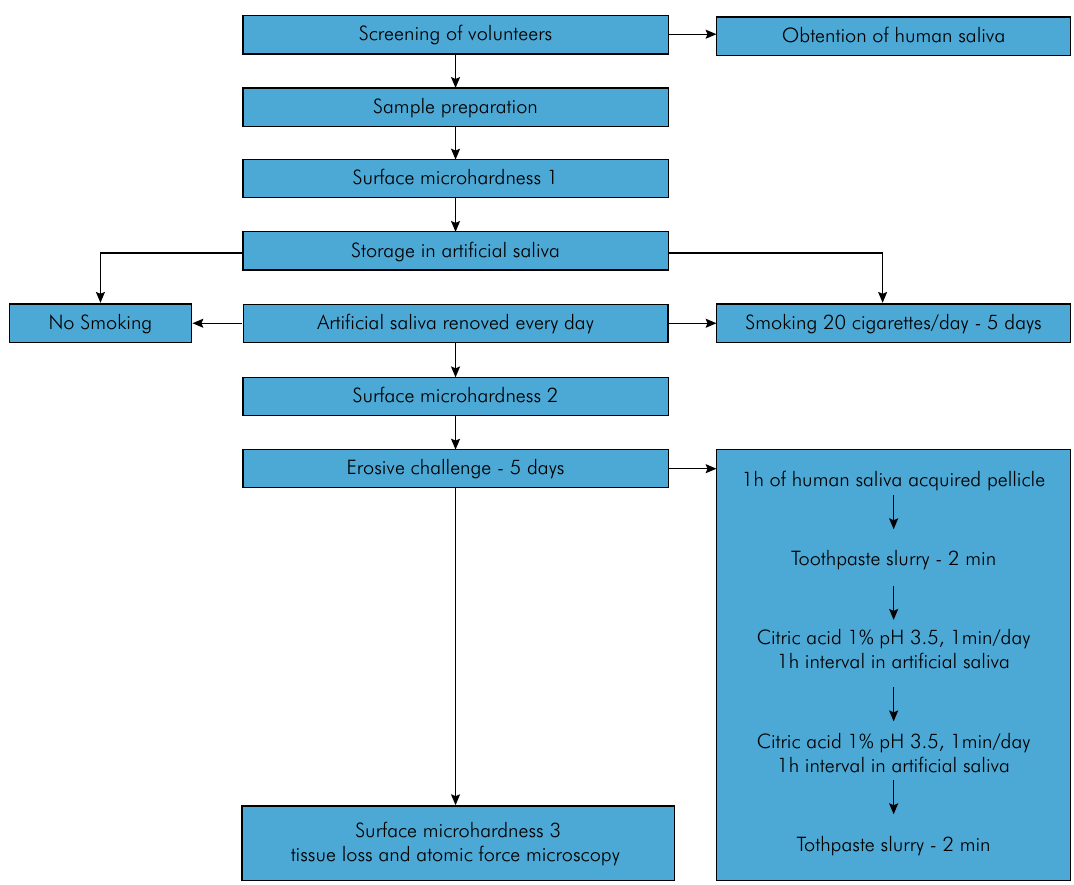
Figure 1. Flow diagram of the experimental